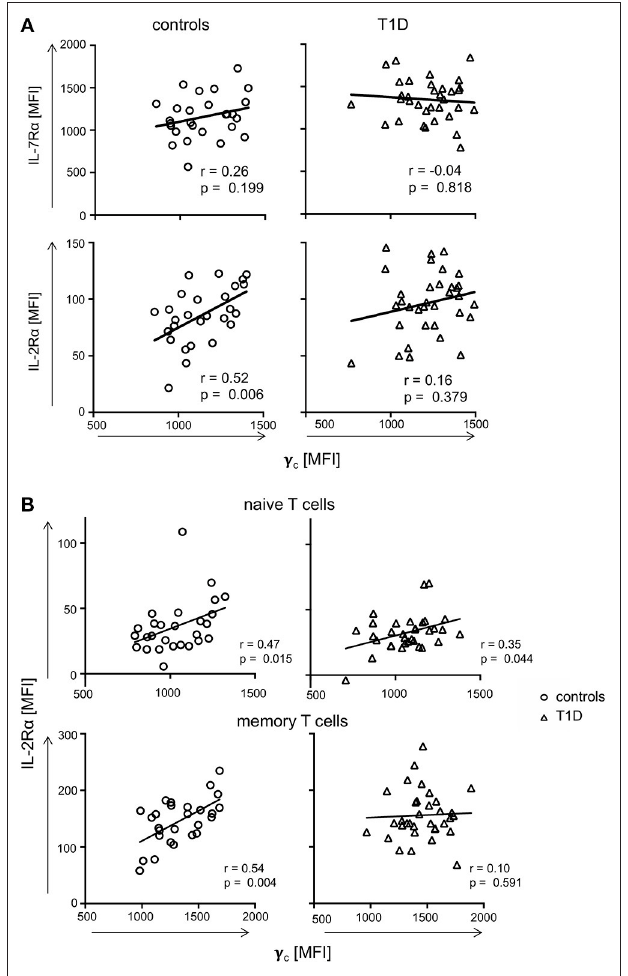
FIGURE 3 | Correlations of γ c with IL-7R α and IL-2R α . (A) Correlations of IL-7R α (upper panels) and IL-2R α (lower panels) with γ c on CD4 + T-cells are shown for healthy controls (left graphs, n = 27, open circles) and T1D patients (right graphs, n = 34, open triangles). (B) Correlations of IL-2R α with γ c on naïve (i.e., CD45RA high CCR7 high ) (upper panels) and memory CD45RA low (lower panels) CD4 + T-cells are shown for healthy controls (left panels, n = 27, open circles) and T1D patients (right panels, n = 34, open triangles). (A,B) Spearman rank correlation coefficients r and p -values are indicated. A trend line was fitted by linear regression analysis.